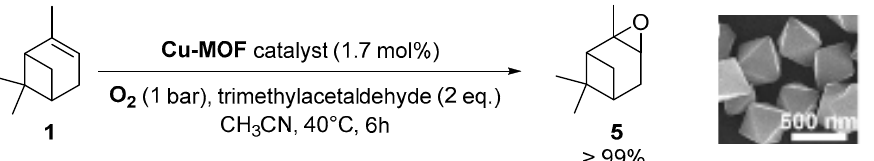
Table 8. Oxidation of α -pinene 1 catalyzed by cobalt(III)-exchanged zeolite Y. Influence of the cobalt content and the co-cations a (adapted from reference [40]).